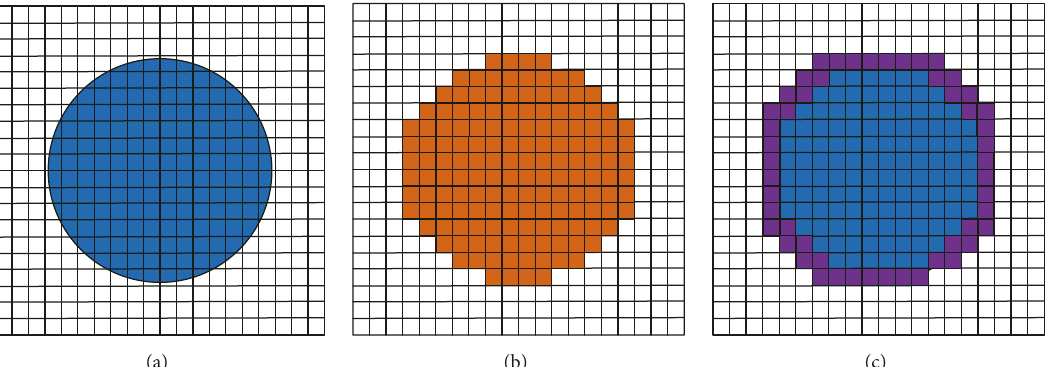
Figure 3: Schematicview for the subdivisions of a circle.(a) An actual model for a circle.(b) The subdivision diagram using the conventional ladder approximation. (c) The conformal grid for a circle.